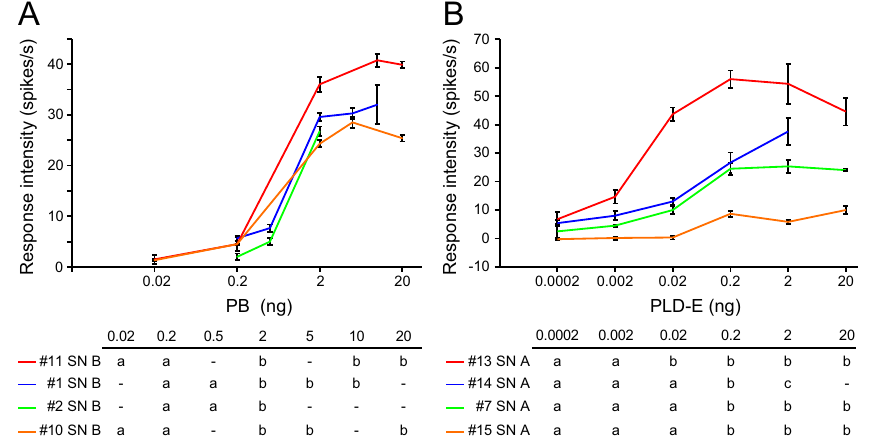
Figure 5. Dose-response curves of PB-SNs ( A ) and PLD-E-SNs ( B ). The averaged “R − R0” values of four PB-SNs ( A ) and four PLD-E-SNs ( B ) to a given concentration of pheromones are plotted with the standard error (vertical bars). Response spectra of four PB-SNs and four PLD-E-SNs are denoted in Fig. 3F (see sample numbers). In each of recordings, response intensities to different concentrations of pheromones are compared (one-way ANOVA and post-hoc Tukey’s test), and the same alphabet letters represent no statistical significant differences (P >